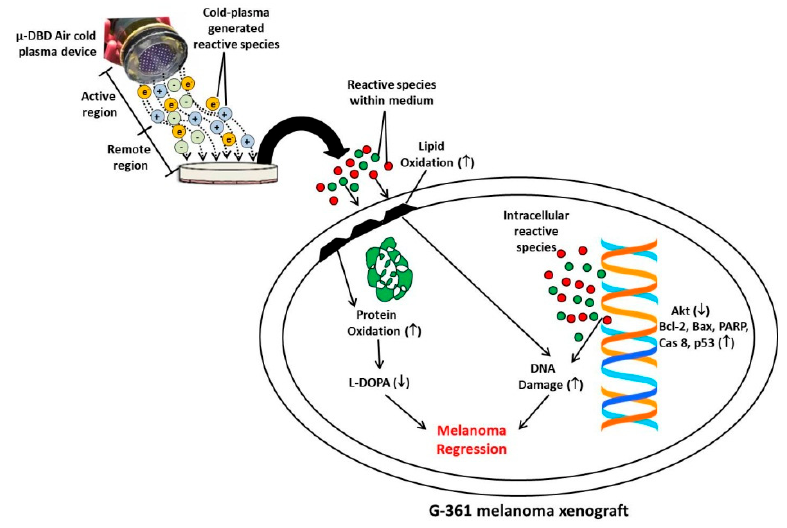
Figure 6. Plausible mechanism of PAM-induced damage or alteration in the G-361 melanoma xenograft in mice model.